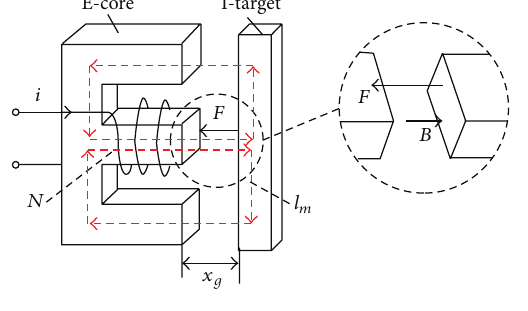
Figure 2: Sketches of the E/I actuator.